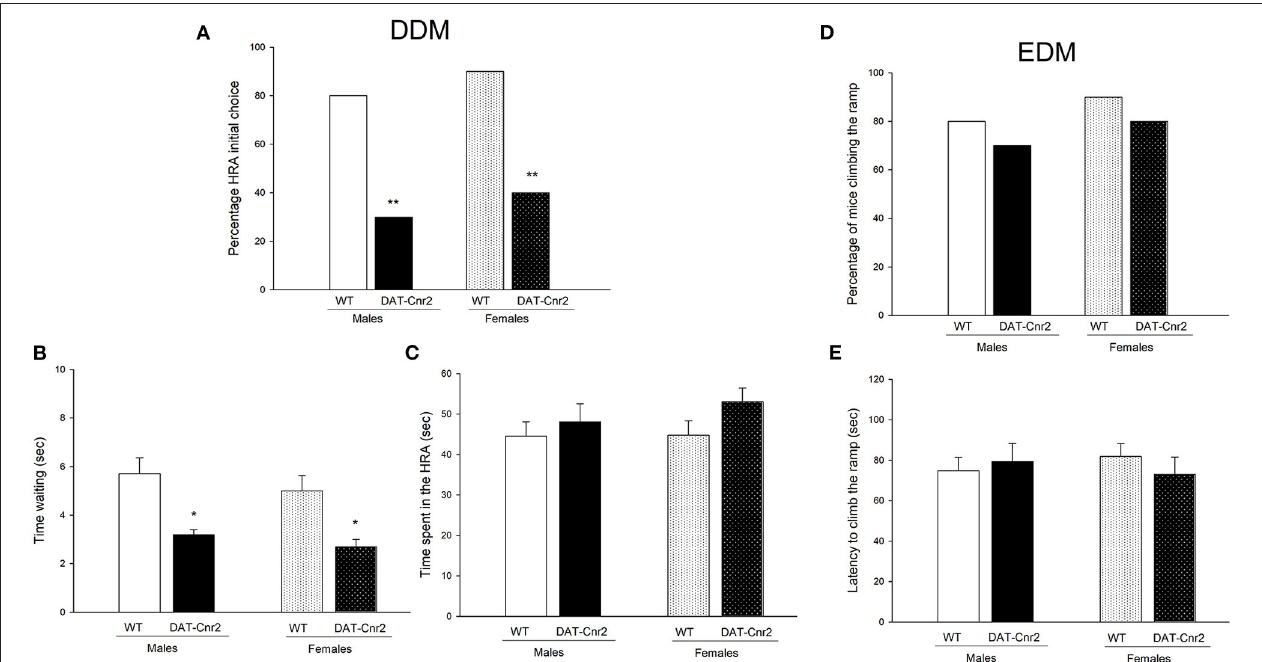
FIGURE 4 | Performance in DDM and EDM. (A) shows the percentage of mice who chose the HRA as its first choice, exhibited in adolescent male and female mice ** P < 0.01, Fisher F test for (A) . The time spent near by the barrier (i.e. waiting time) is shown in (B) and in (C) , the time spent in the HRA by the animals is shown. The white with dots represent the WT mice and the black and the black with dots represent DAT-Cnr2 mice. The clear bars are the males, and the bars with dots represent the females. Data are expressed as mean ± SEM ( n = 10 mice per group). Two-way ANOVA followed by Tukey * p < 0.05 for genotypes. (D) shows the percentage of animals climbing to reach the HR in the EDM, and (E) exhibits the latency to climb the ramp to reach the HR.